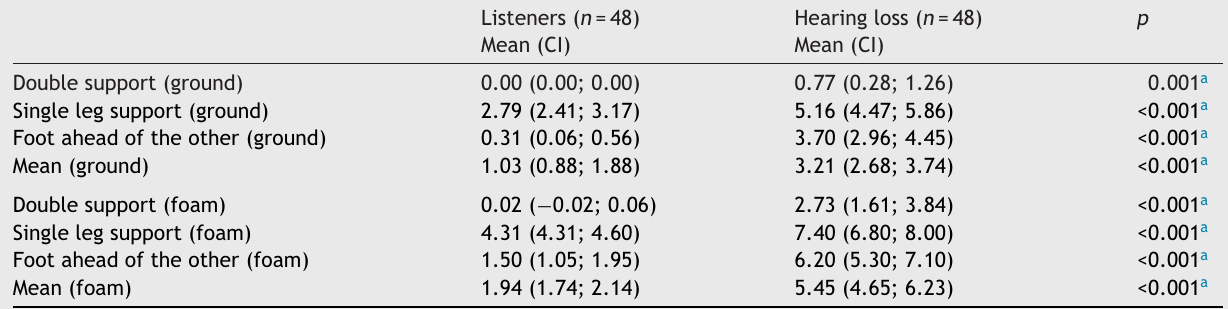
Mean and confidence interval values for performance of postural control of students listeners and with sensorineural hearing loss of the sample ( n = 96).